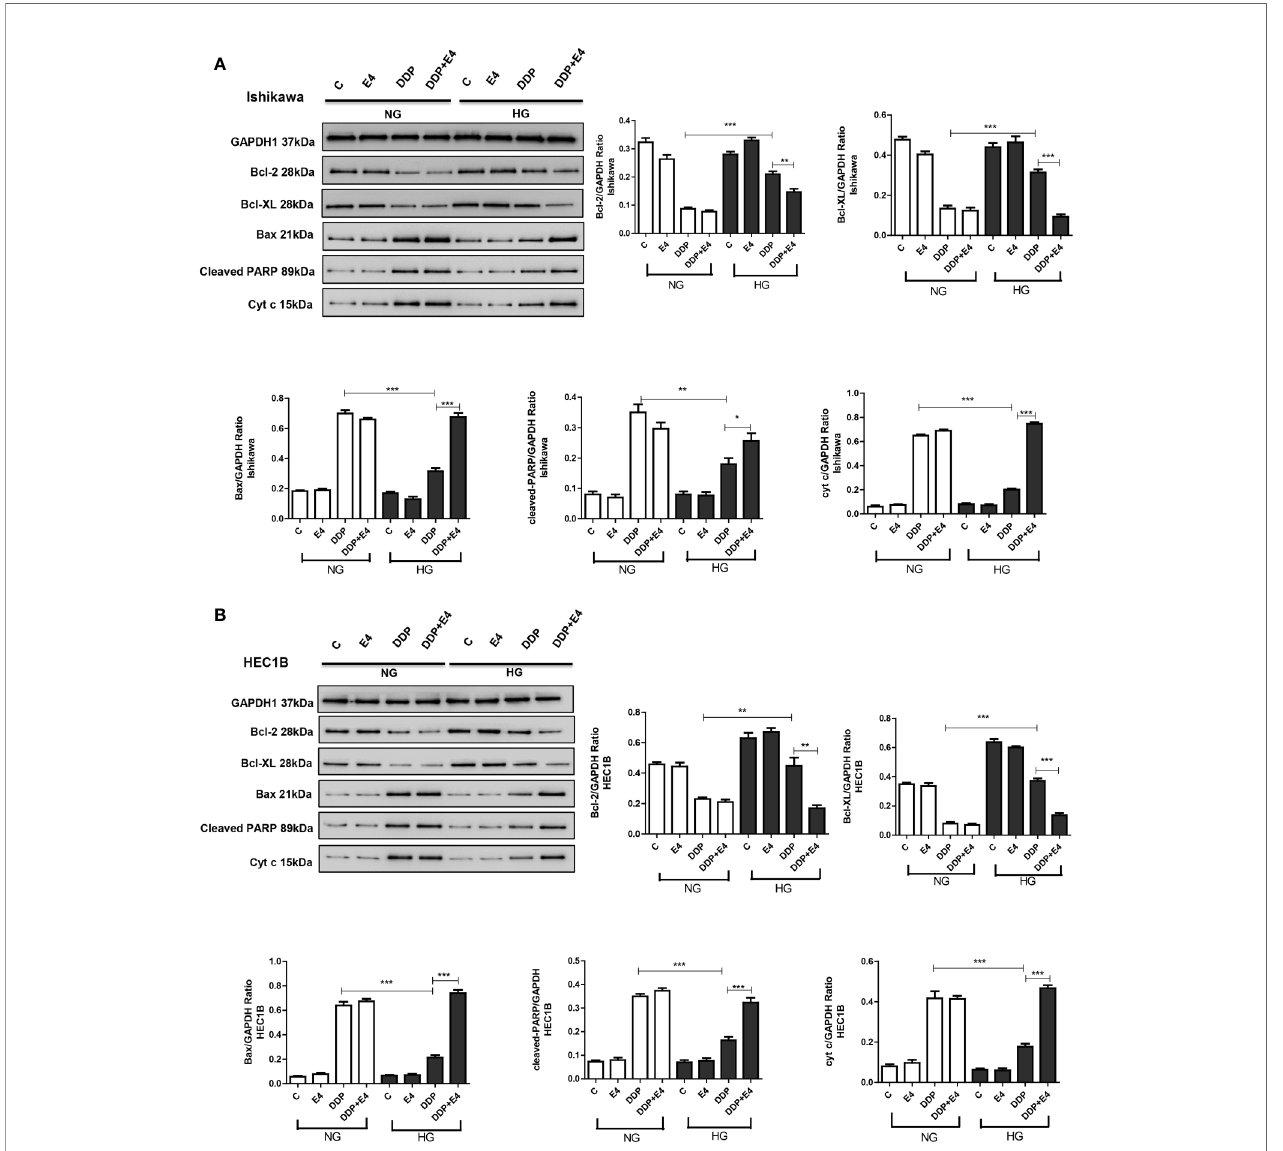
FIGURE 5 | Effects of high glucose (HG), DDP, and Exe-4 on Bcl-2, Bcl-XL, Bax, cleaved PARP, and cytosolic cytochrome c levels in Ishikawa and HEC1B cells. Protein levels were assessed by immunoblot, with GAPDH as a loading control. Data for Ishikawa (A) and HEC1B (B) cells are shown. Measurements were performed in triplicate. *p < 0.05, **p < 0.01, ***p < 0.001, DDP in HG vs. DDP in NG, DDP+Exe-4 vs. DDP in